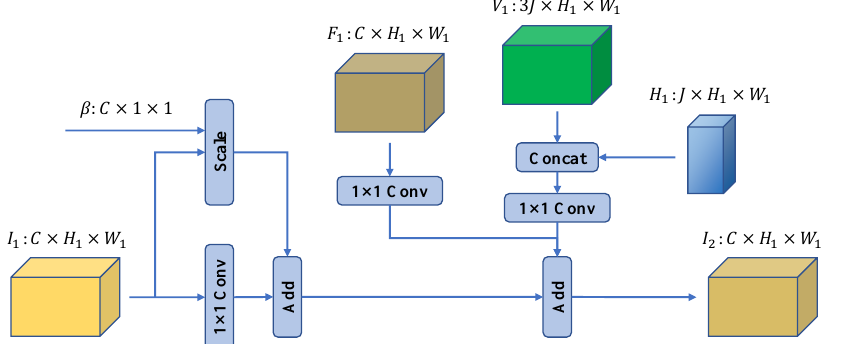
Figure 7. Structure of the proposed soft input aggregation module. β represents the learnable channel-wise factor. Concat denotes the concatenate operation. Inputs of the proposed soft input aggregation module are I 1 , F 1 , V 1 , and H 1 . Output is I 2 , the input features of the second stage.